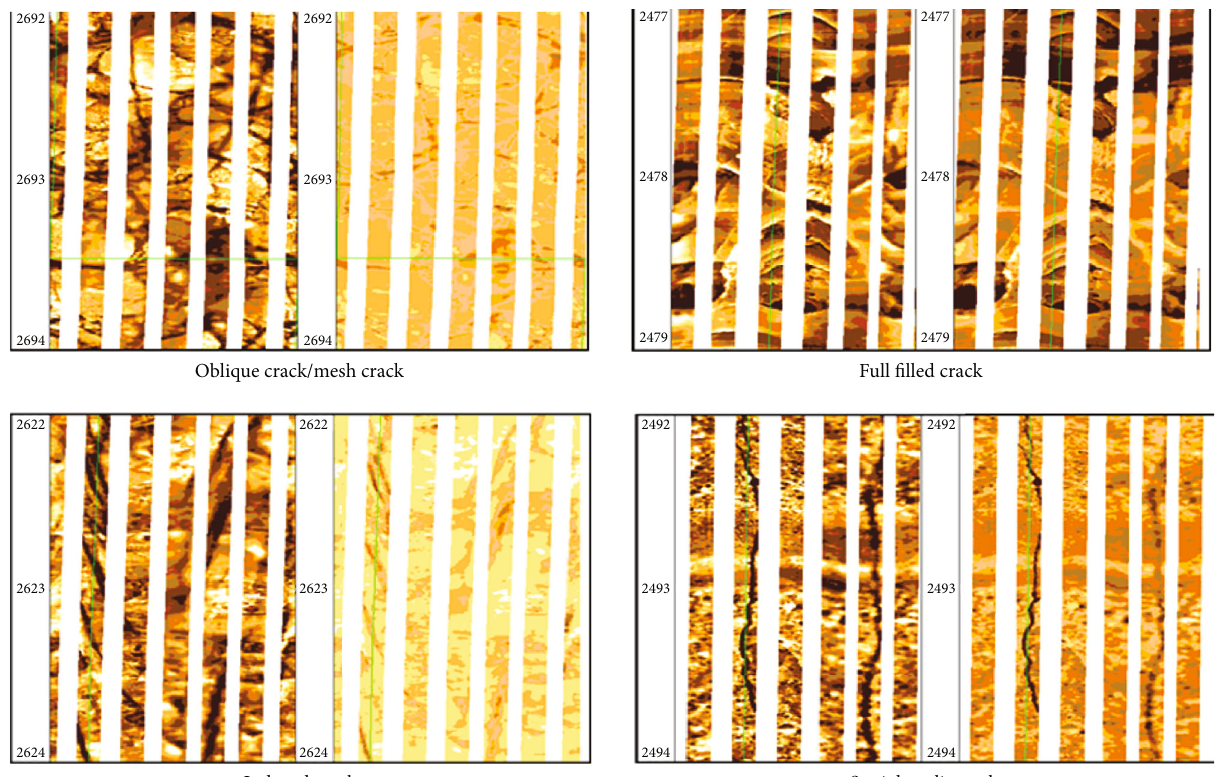
Figure 2: XRMI image characteristics of fractures in well Che